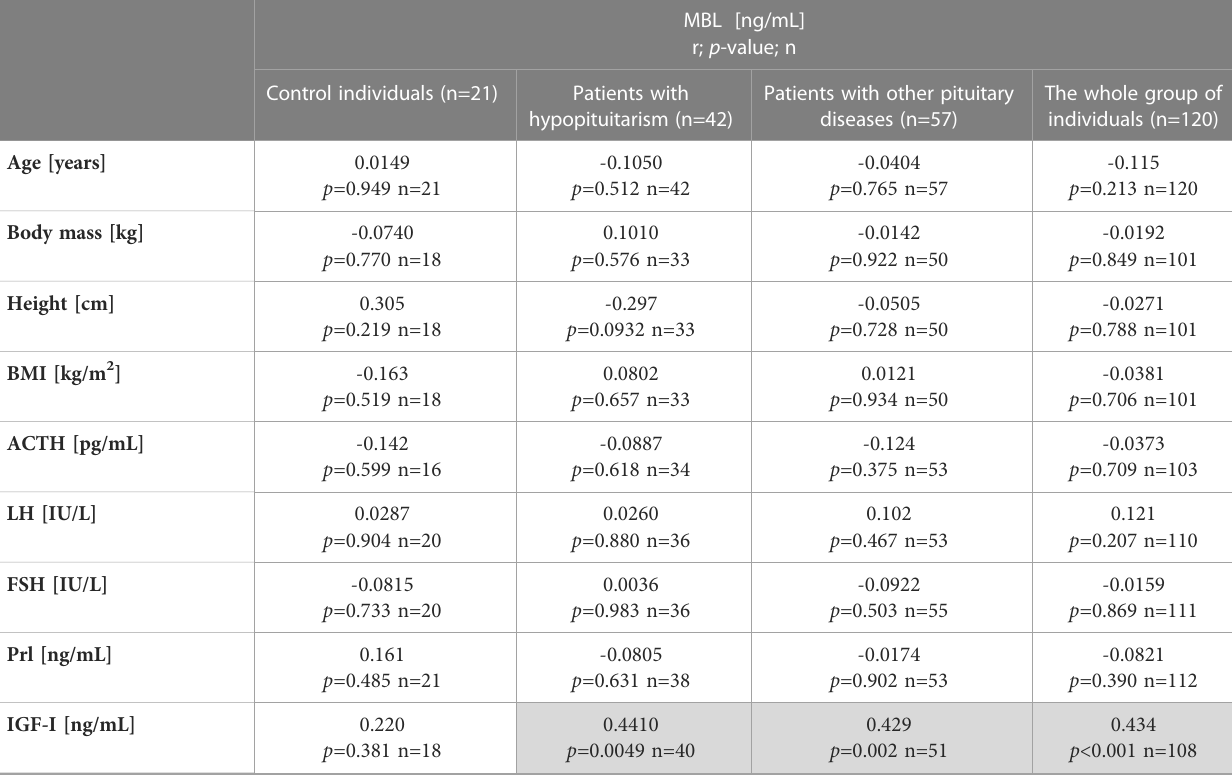
TABLE 3 Correlations between mannan-binding lectin (MBL) level and clinical/laboratory parameters in 4 groups considered: Control individuals (n=21), patients with hypopituitarism (n=42), patients with other pituitary diseases (n=57), and the whole group of individuals